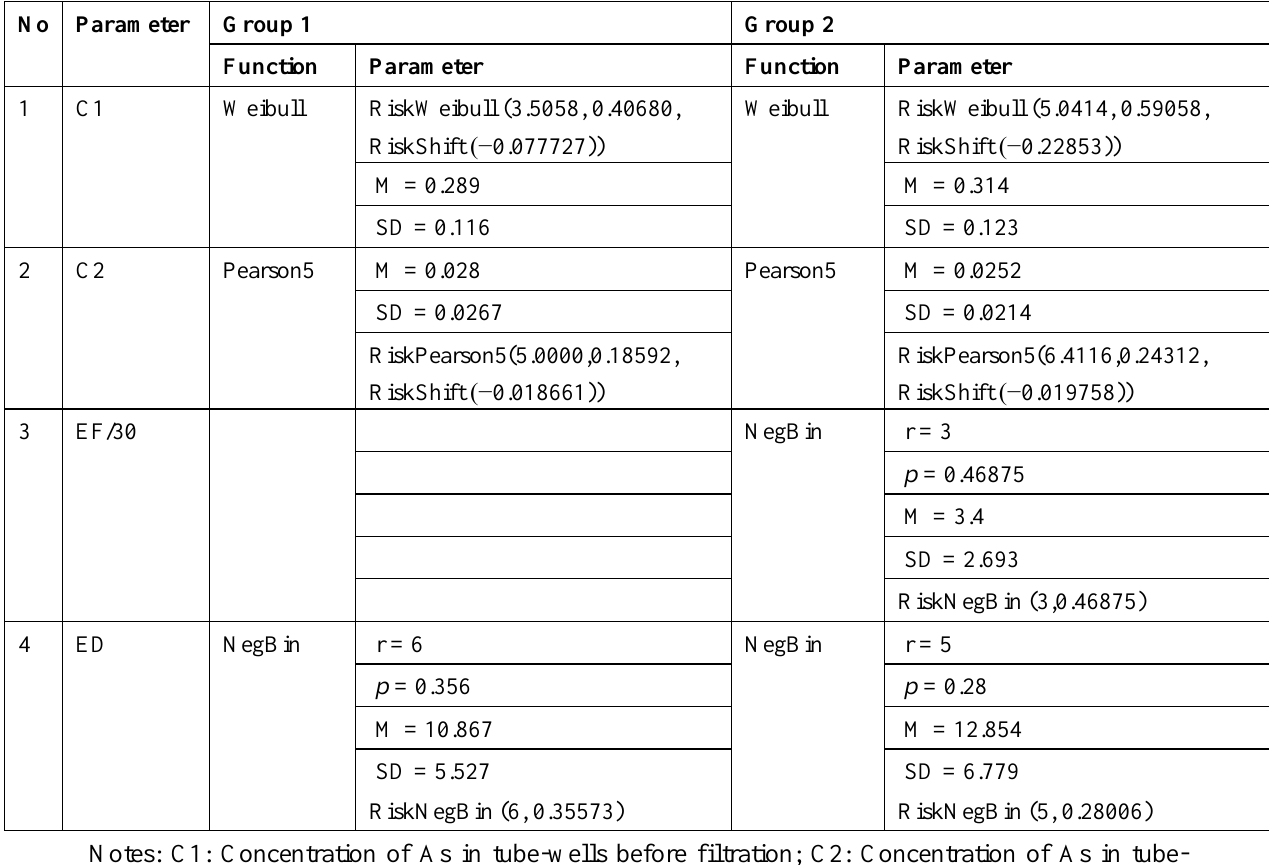
Table 2. The parameters of the fitted distributions.